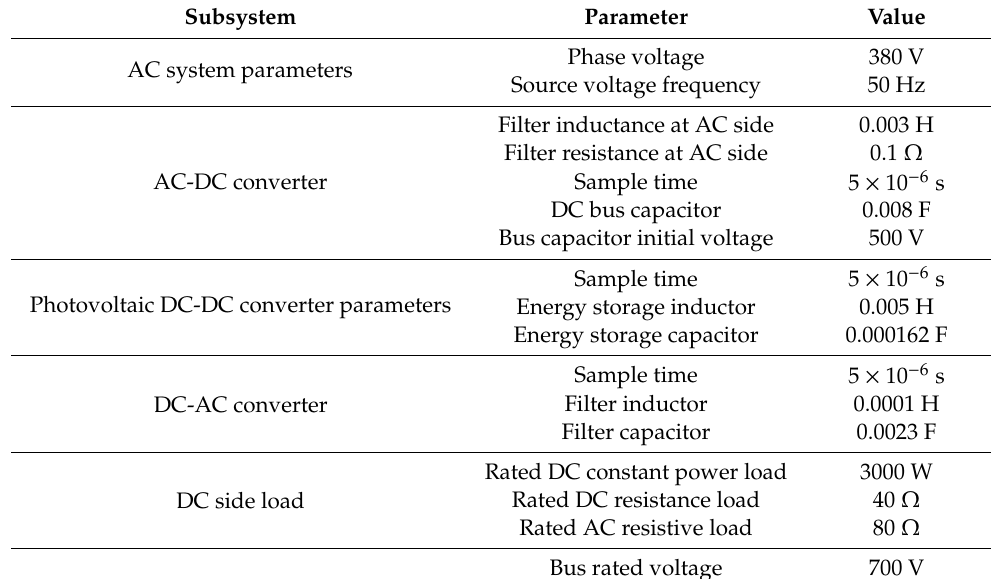
Table 1. System parameters.